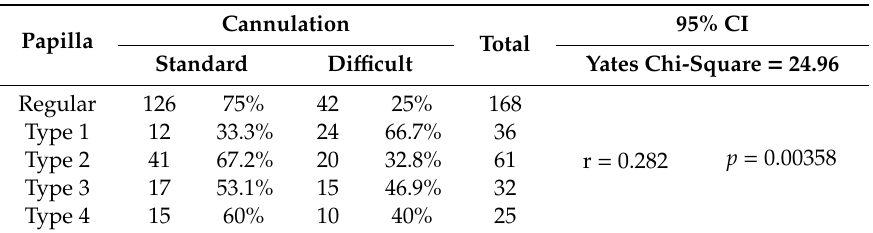
Table 2. Di ffi cult cannulation among di ff erent papilla types.